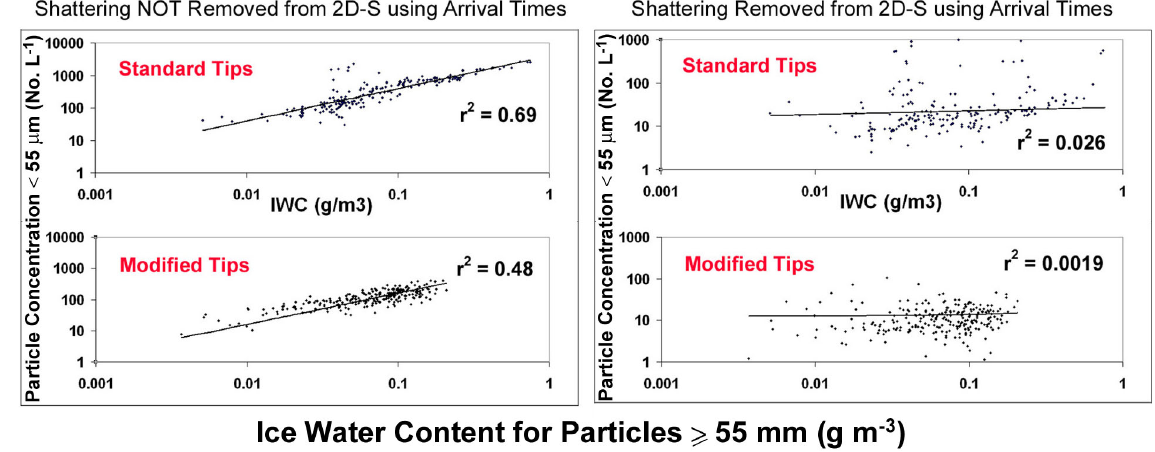
Fig. 9. Scatter plots of the concentration of ice particles ( < 55µm) versus ice water content = > 55µm. Data were collected during the AIIE field project with a 2D-S probe installed on the NRC Convair 580. Data were collected with standard tips from 17:54:53–20:16:44UTC, 1 April 2009. Data were collected with modified tips from 14:32:32–16:24:37UTC, 4 April 2009. The 2D-S probe was flown with standard tips on one flight (top two panels), then with modified tips in similar conditions on a second flight (bottom two panels). Effect of the arrival time algorithm to remove shattering is shown on plots on the right